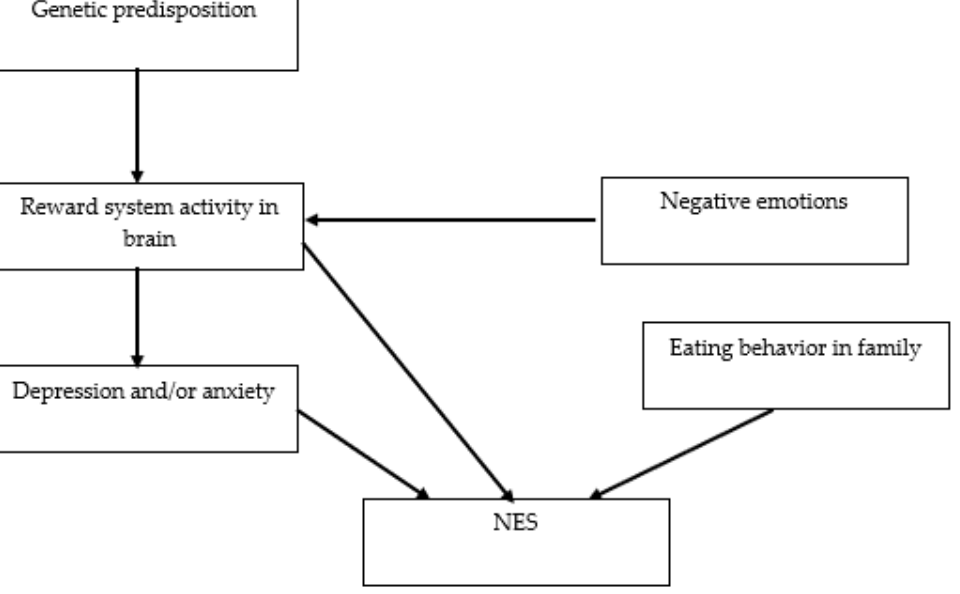
Figure 5. The network of relationships between risk factors for the development of NES. NES: night eating syndrome.